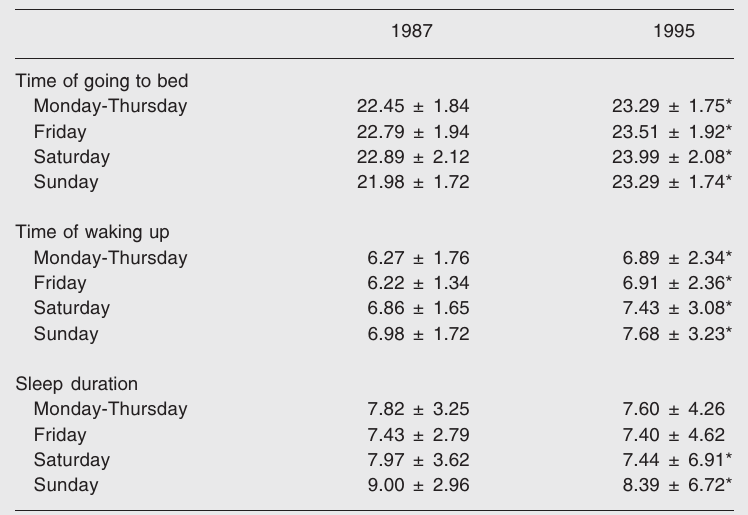
Table 2. Sleeping times and sleep duration found in surveys carried out in 1987 and 1995 in the city of São